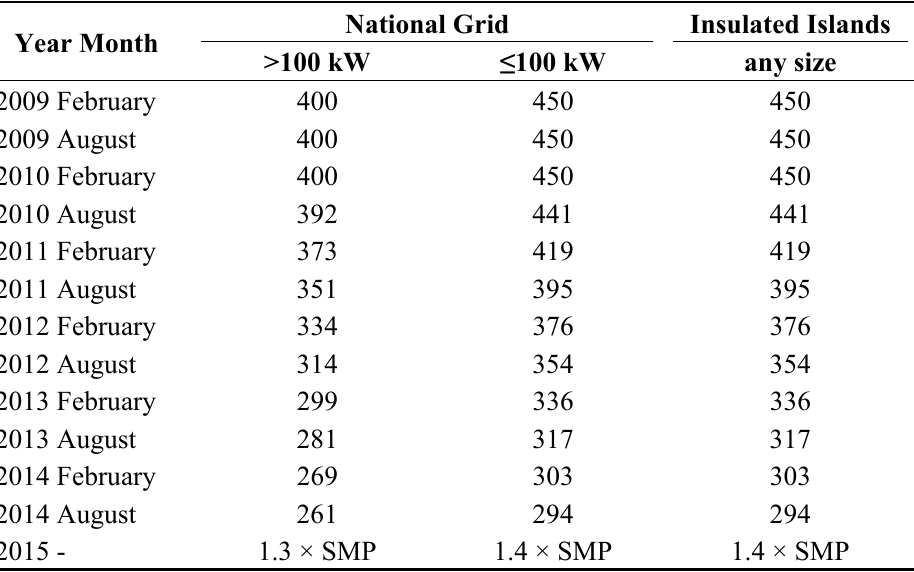
Table 1. Evolution of feed-in-tariff (in